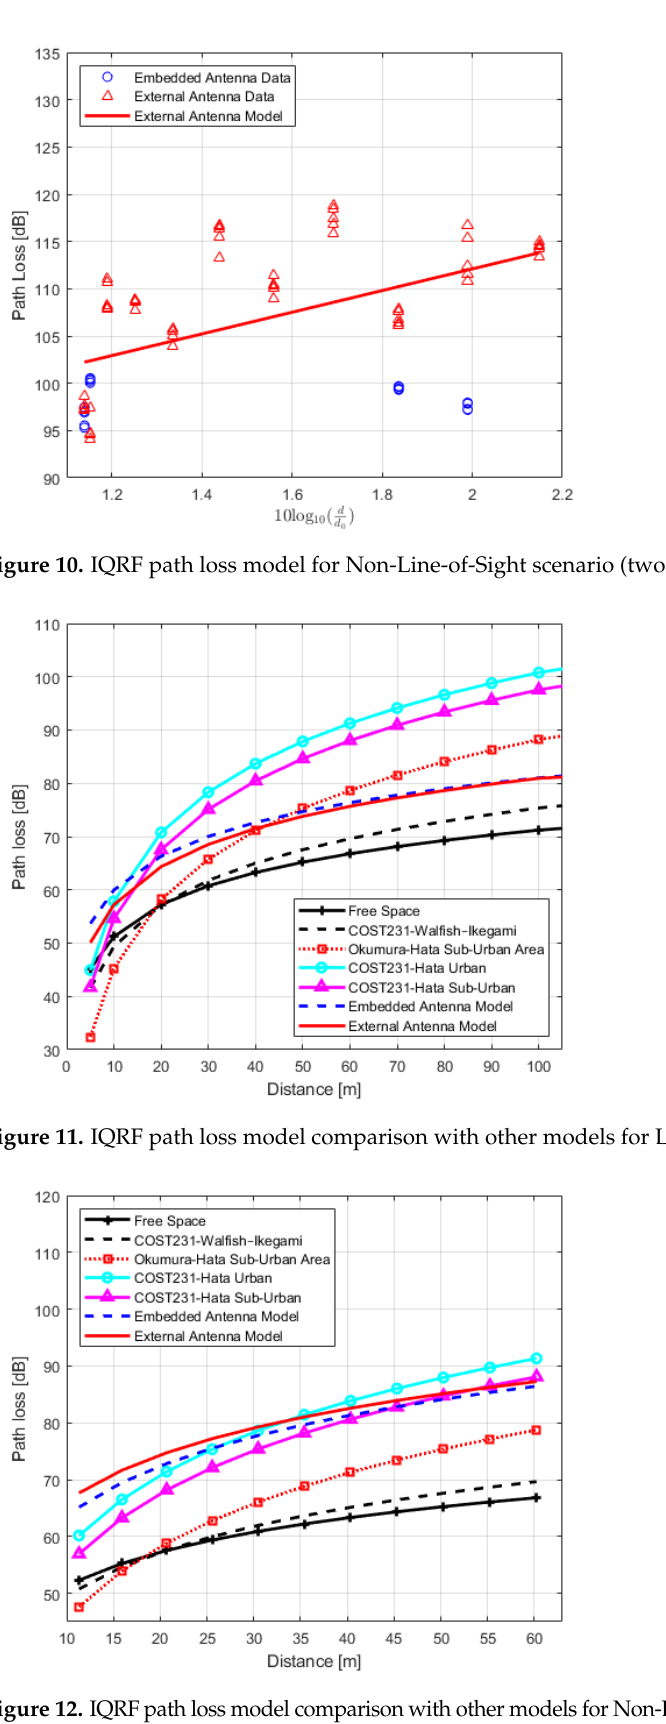
Figure 12. IQRF path loss model comparison with other models for Non-Line-of-Sight scenario